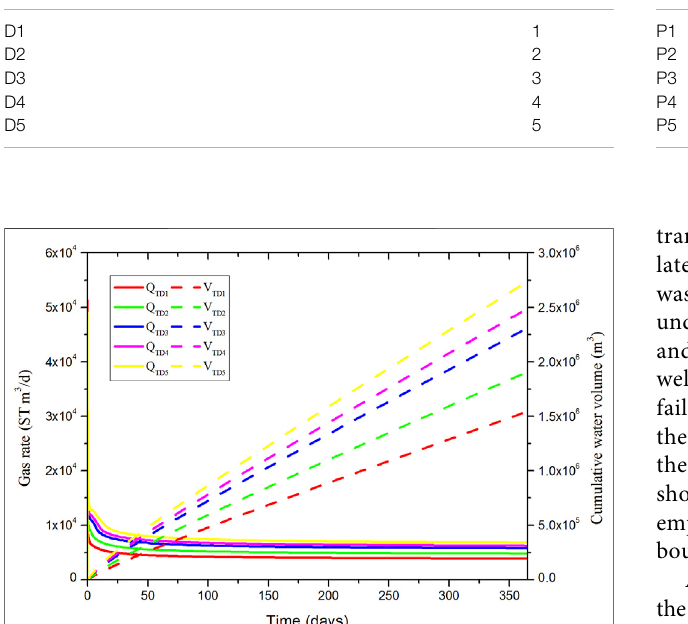
TABLE 3 | Fracture permeability and corresponding calculation case.